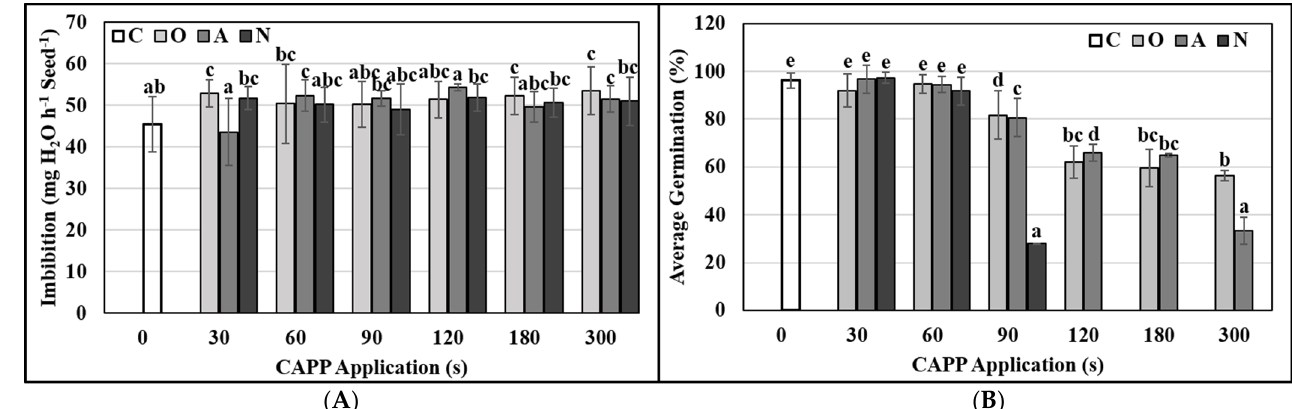
Figure 3. Imbibition ( A ) and germination ( B ) (%) of maize grains after Cold Atmospheric Pressure Plasma (CAPP) treatment. Variants: C—control/untreated maize grains; O30 ‒ O300: maize grains treated with plasma generated in an oxygen atmosphere for 30, 60, 90, 120, 180 or 300 s; A30 ‒ A300: maize grains treated with plasma generated in ambient air for 30, 60, 90, 120, 180 or 300 s; N30 ‒ N300: maize grains treated with plasma generated in a nitrogen atmosphere for 30, 60, 90, 120, 180 or 300 s. Different letters indicate significant difference at p -value < 0.05, bars are means of ten experimental runs (one run represents 50 grains per variant, n = 500) ± SD to LSD ANOVA test.